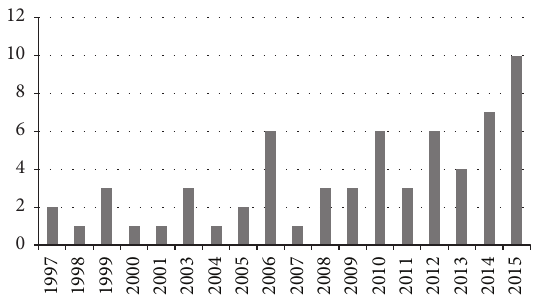
Figure 1: Number of clinical study